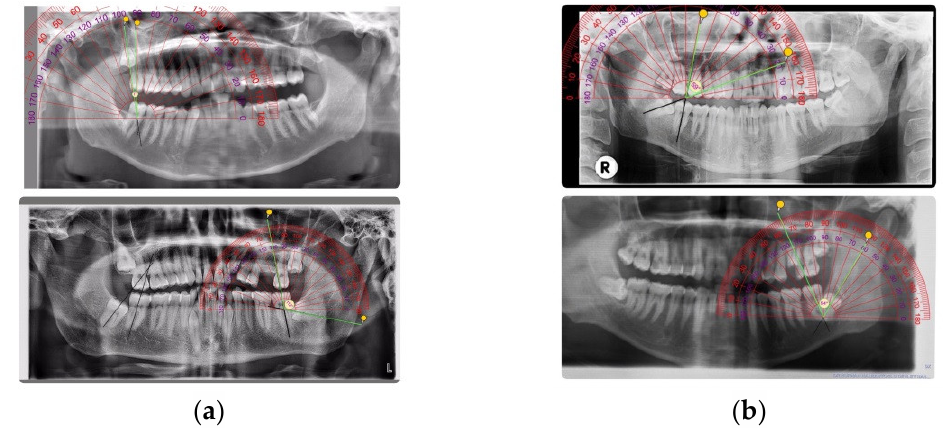
Figure 1. ( a ) Vertical and horizontal impaction; ( b ) Mesioangular and distoangular impaction.